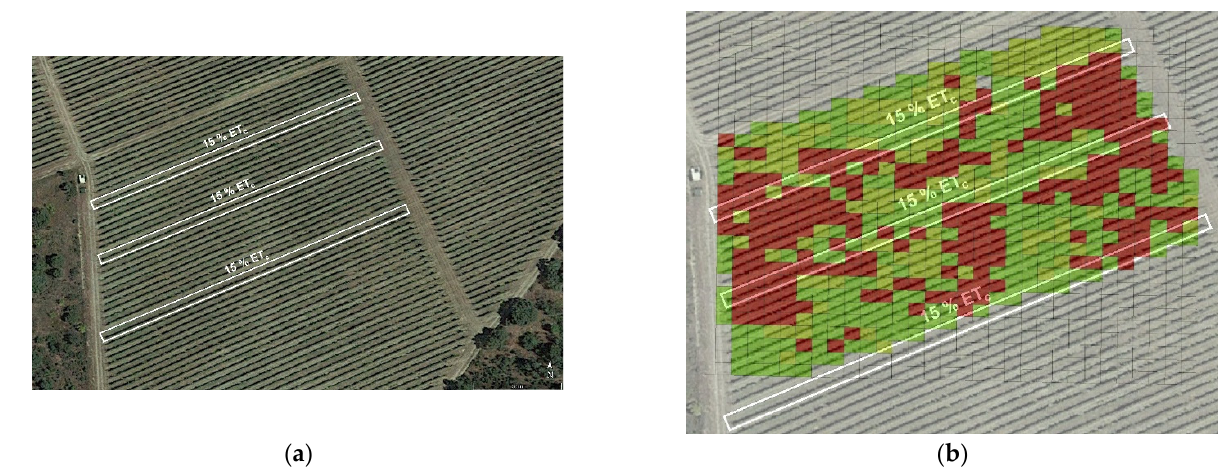
Figure 17. Monitored vineyard: ( a ) satellite image with deficit irrigation lines; and ( b ) potential correlation between low-irrigated rows and high stress deduced from the aggregated zoning map in Figure 16.